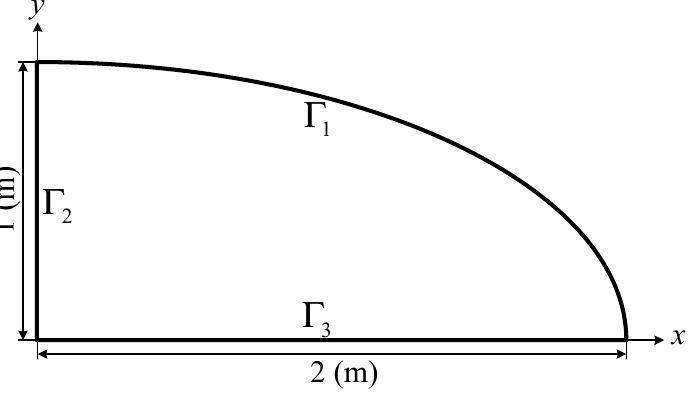
Figure 2. The configuration of the boundary condition.